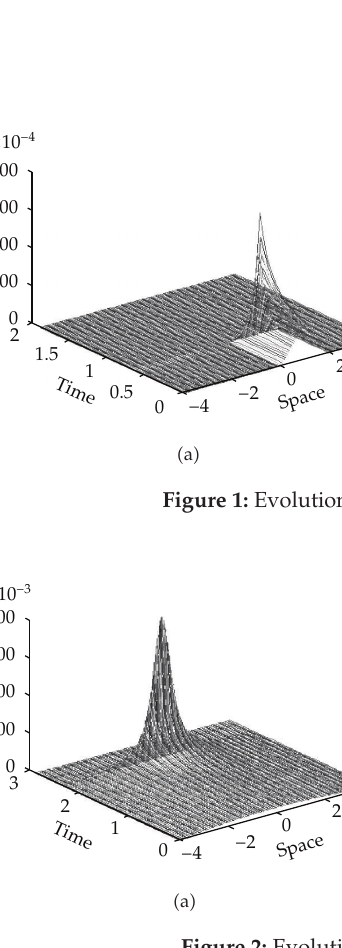
Figure 2: Evolution in time, symmetric